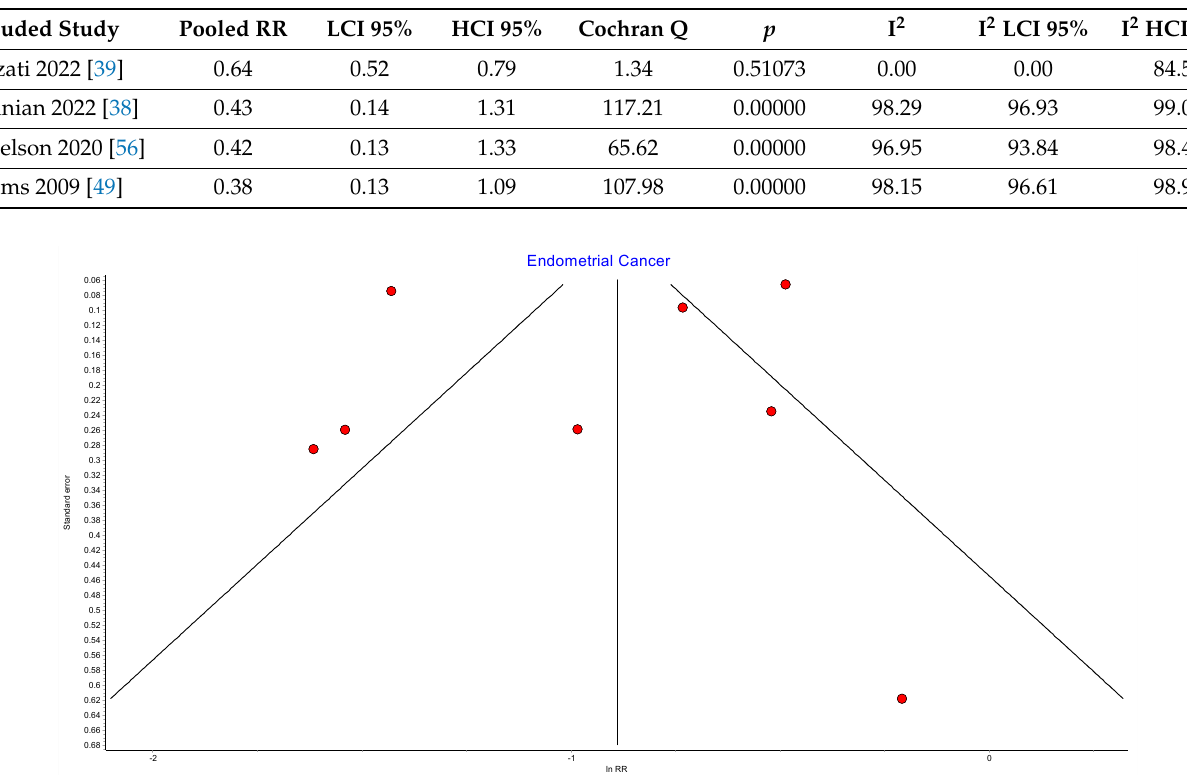
Figure A7. Endometrial cancer random effects model.